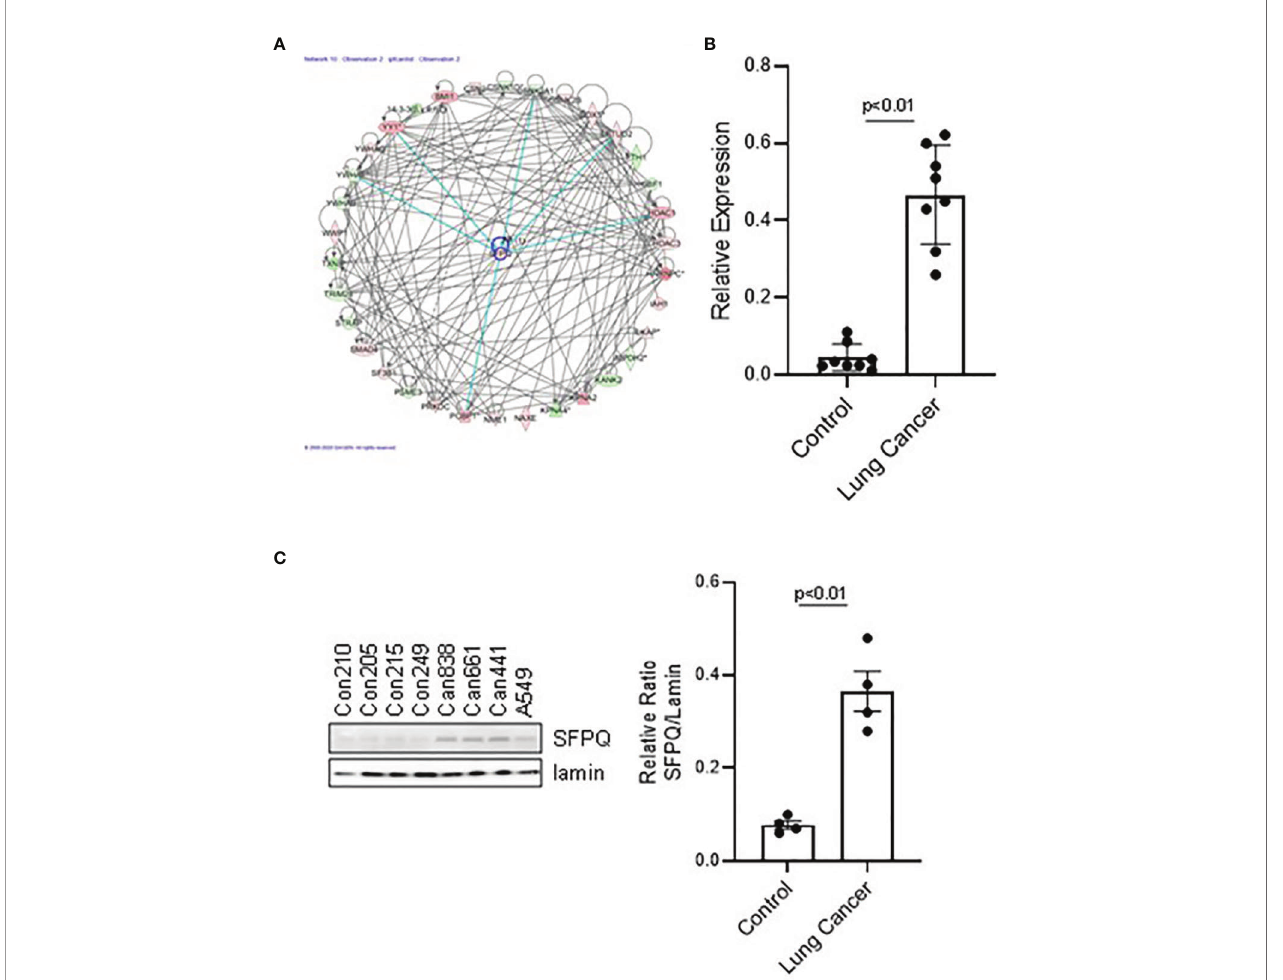
FIGURE 2 | The expression level of SFPQ in lung NSC cancer MSC is higher than that in IPF and control MSC. (A) Predicted interactive proteins of SFPQ and their functional interactions are shown by IPA pathway analysis. Primary cell lines were used to measure SFPQ expression level in MSCs. The MSCs were sorted and veri fi ed from 4 normal lung cell lines (Con210, Con205, Con215, Con249) and 4 lung NSC cancer cell lines, (Can661, Can522, Can838 and A549) as described in method. (B, C) SFPQ expression was analyzed with (B) RT-PCR in mRNA and (C) western blot analysis in protein levels. Densitometry values were shown in the right graph. All data are shown as mean ± S.E. ( n =3 independent